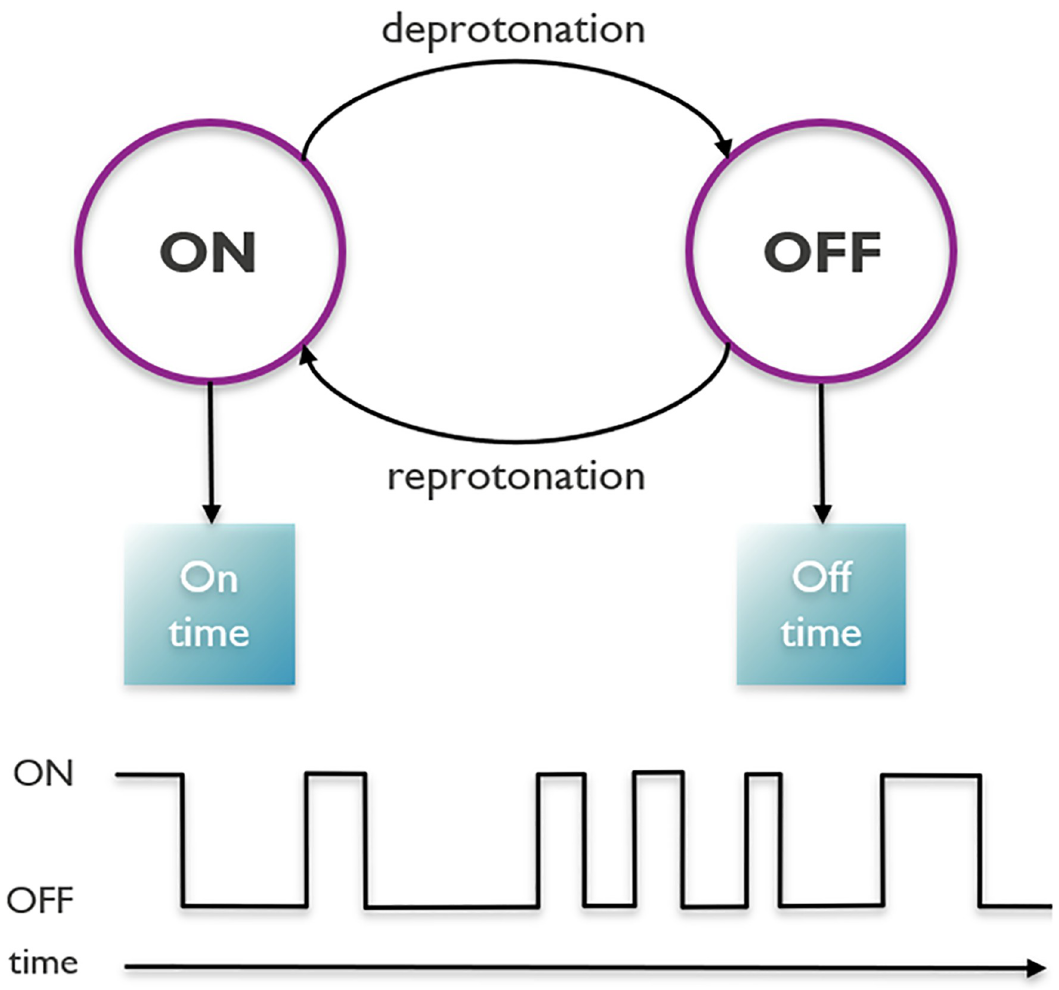
Fig 3. The simulation model. There are two states for a given terminal amino acid, and two transitions between these states. A third transition (enzyme cleaving, not shown) leads from the states of the current terminal amino acid to the states of the next, by cleaving the terminal amino acid from the peptide. The amount of time spent in alternating on- and off-states constitutes the measured signal. These on- and off-times are exponentially